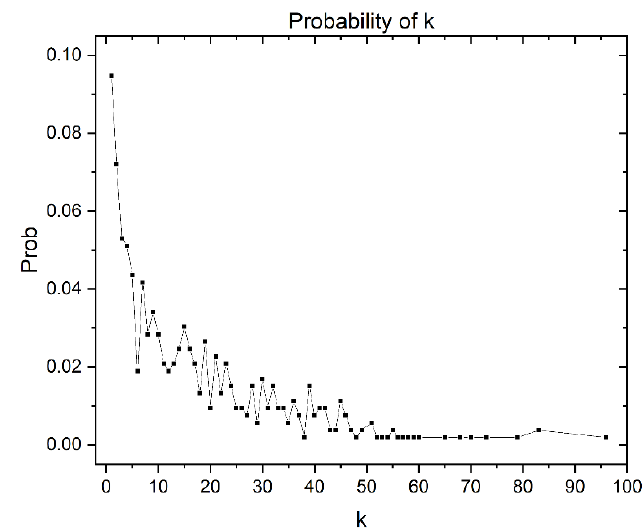
Figure 7. Degree distribution of the 528 giant components, where k is the vertex degree.